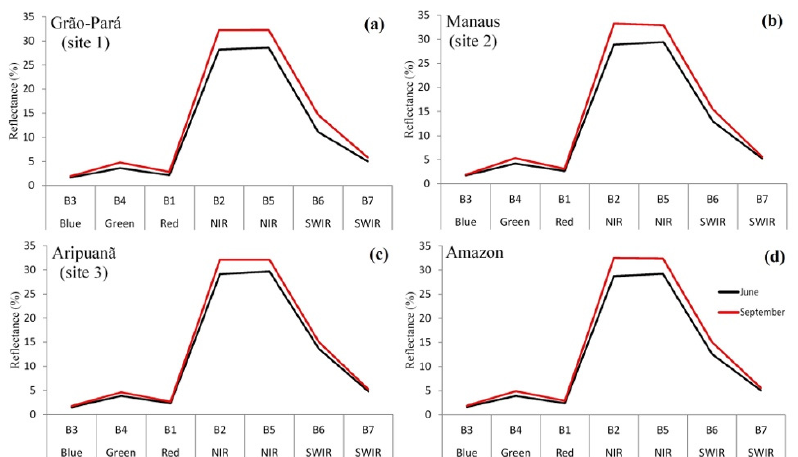
Figure 5. Monthly average surface reflectance (2000–2014) of dense ombrophilous forest for MODIS (MAIAC) data non–corrected for bidirectional effects. Spectra are shown for the beginning (June) and end (September) of the dry season over ( a ) site 1, ( b ) site 2, ( c ) site 3, and ( d ) the entire Amazon region ( n = 4500 sampled pixels). The number of pixels per site was 100. Precise MODIS band positioning is indicated in the text.